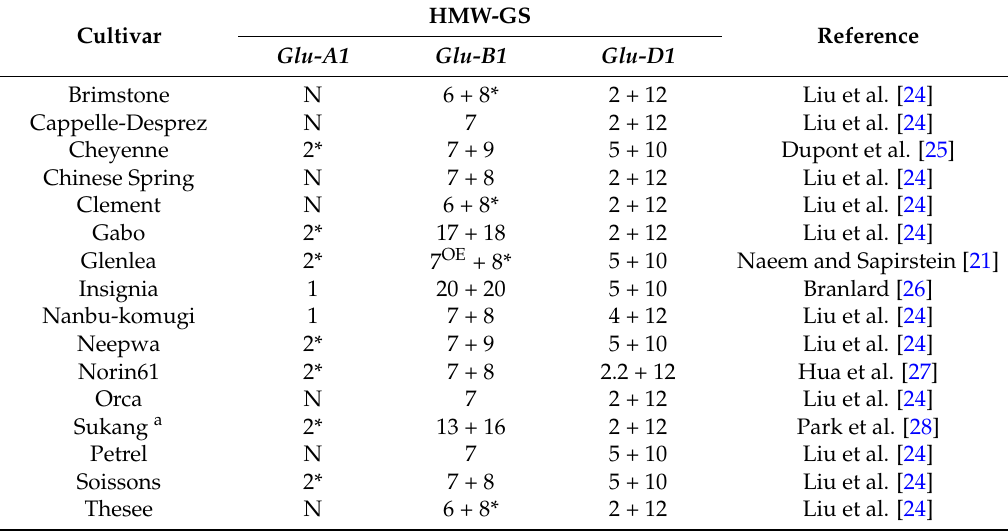
Table 1. Allelic compositions of HMW-GS in standard cultivars.